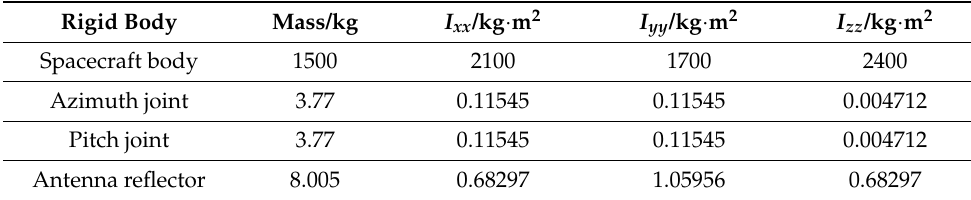
Table 1. Structural parameters of the satellite antenna system.